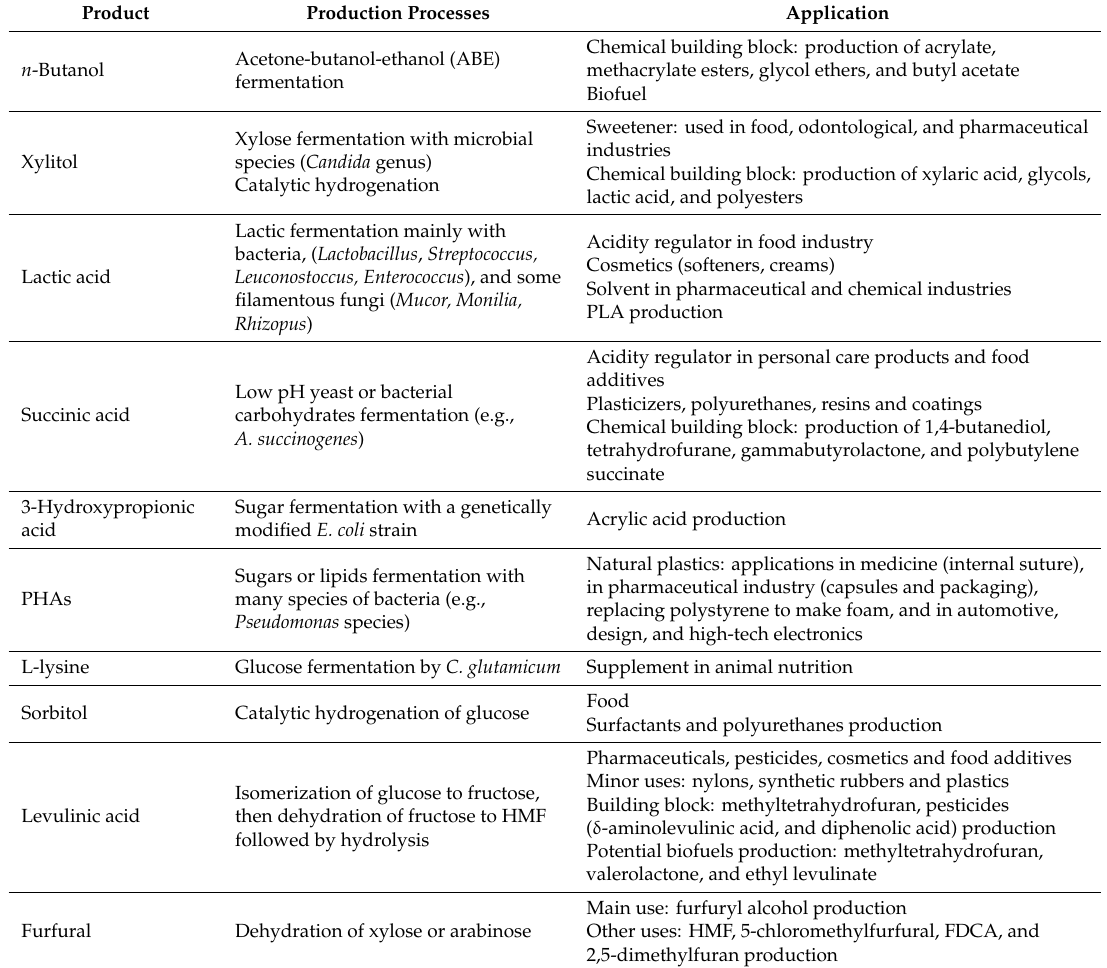
Table 2. List of bio-based products from the sugar